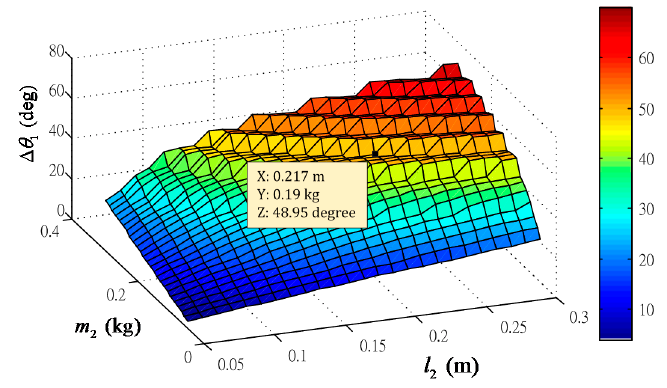
Figure 8. A simulation of the two-link model with different lengths and mass values.